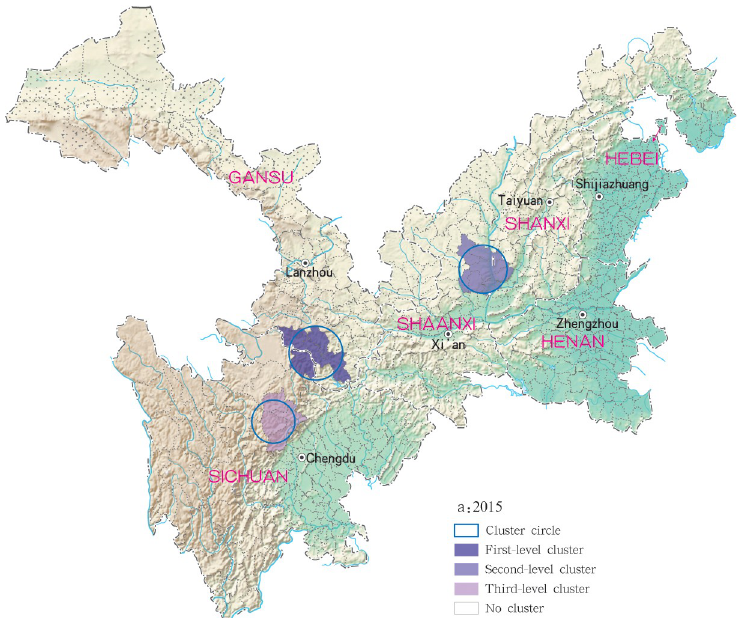
Fig 11. Spatio-temporal clustering analysis of mountain-type zoonotic visceral leishmaniasis incidence in 6 provinces, China in 2015.